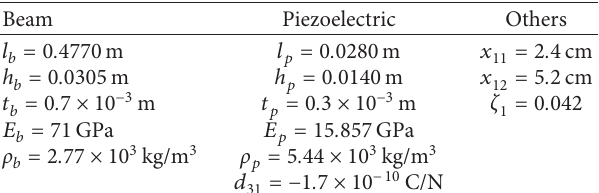
Table 1: Corresponding